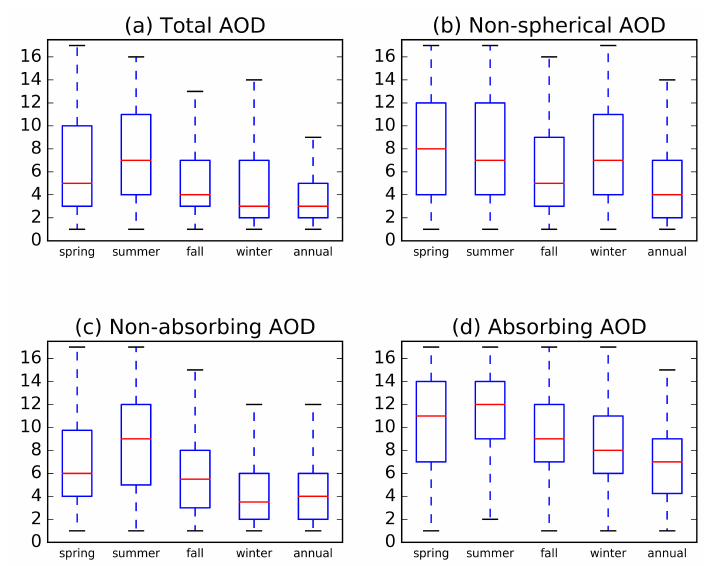
Figure 5. Spatial distributions of the minimum record lengths required to obtain stable climatology of ( a ) total, ( b ) non-spherical, ( c ) non-absorbing, and ( d ) absorbing aerosol optical depths for the four seasons and annual mean within the predefined accuracy levels ( ± 0.01 optical depth for total aerosols, ± 0.004 for nonspherical aerosols, and ± 0.005 for nonabsorbing and absorbing aerosols). Only the data over land were